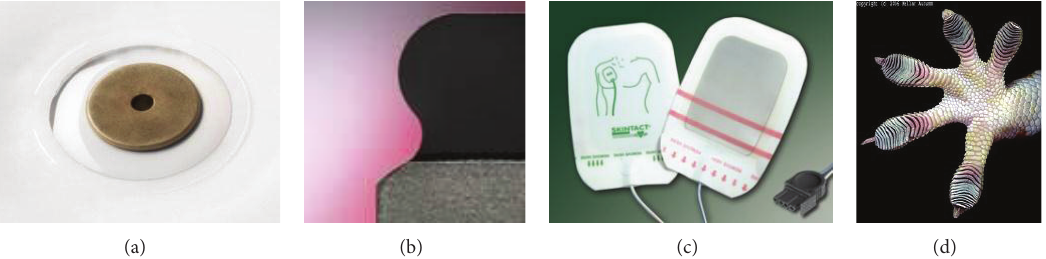
Figure 12: (a) Good electrical contact of ECG electrode made of Ag/AgCl sensor; (b) carbon contact interface; (c) commercial pressure sensitive adhesive; (d) a gecko